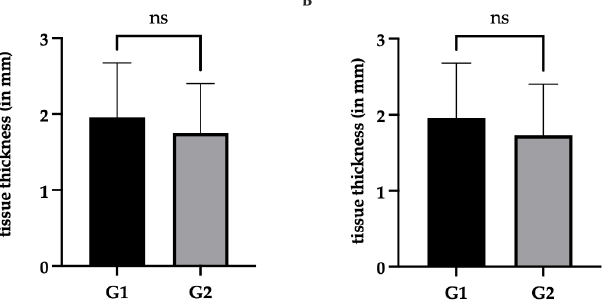
Figure 5. The thickness of keratinized tissue (TKT) in G1 (no bone augmentation) and G2 (bone augmentation). ( A ) all patients included in the study; ( B ) patients with peri-implantitis excluded. Error bars shown in this figure are means ± SD. The abbreviation ns is used for statistically nonsignificant, statistically significant at p ≤ 0.05.